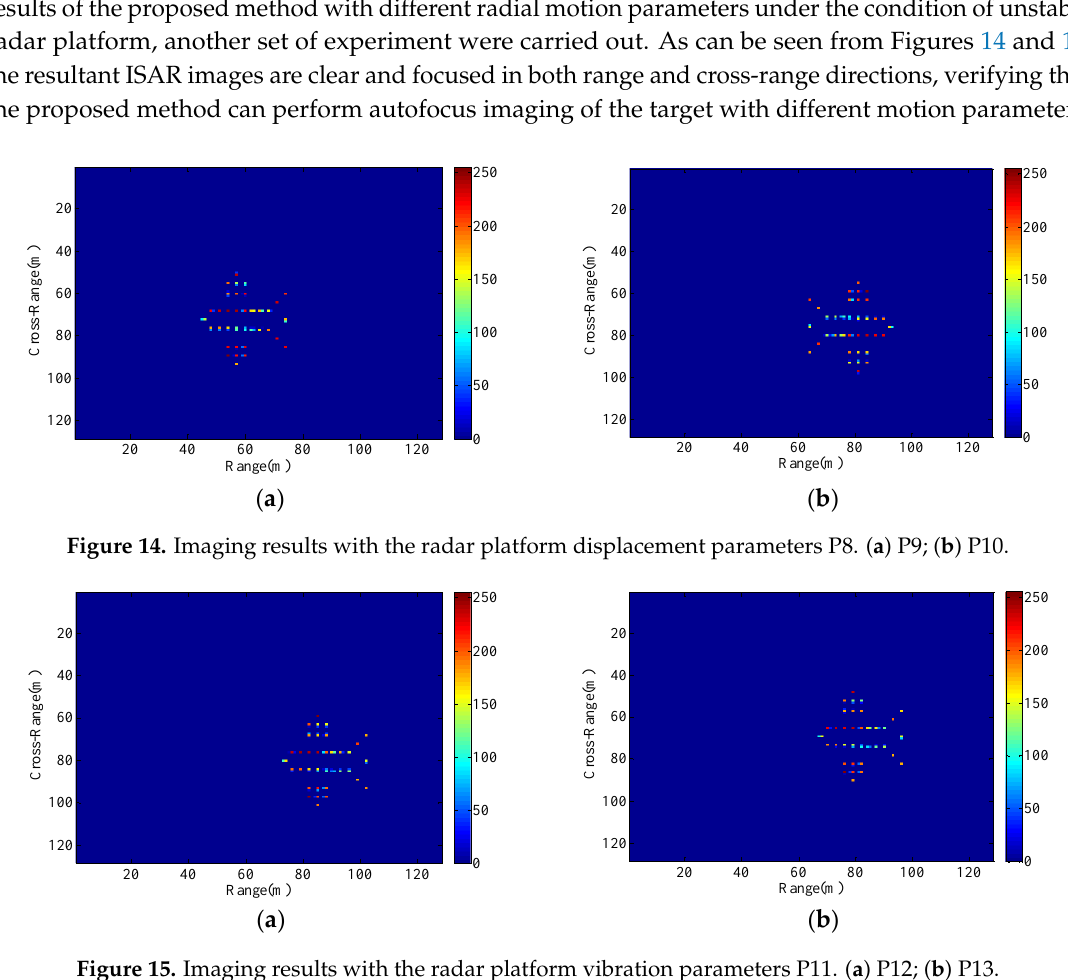
Figure 13. Spectrograms of time pulses. ( a ) before applying the proposed method; ( b ) after applying the proposed method.